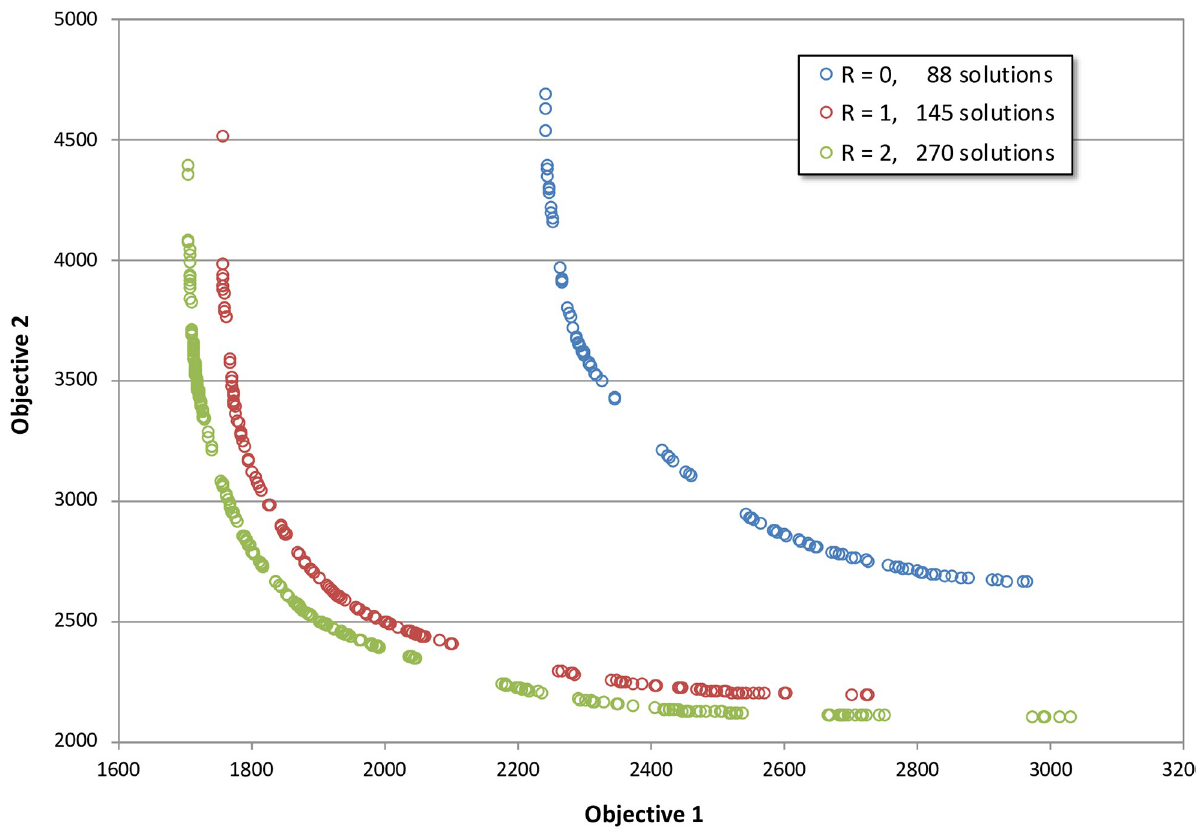
Fig 5. Non-dominated solutions in objective space for R = 0 (blue), R = 1 (red), and R = 2 (green).